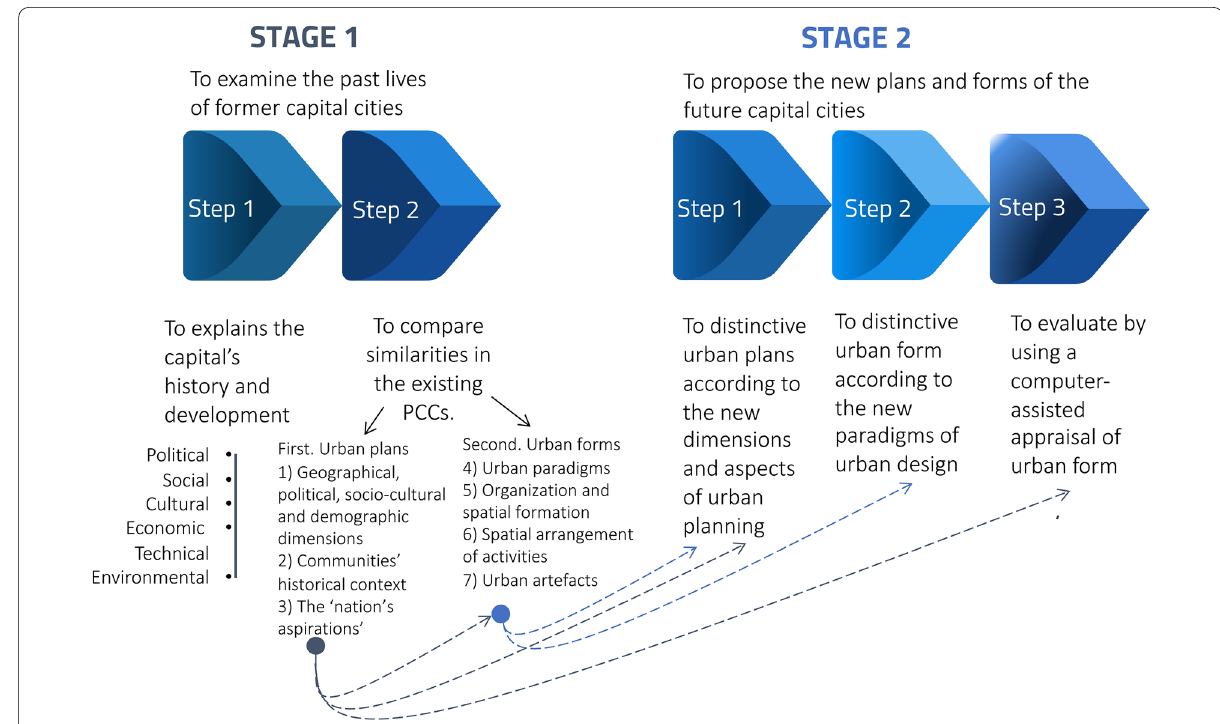
Fig. 7 The framework: Two stages and five steps for avoiding